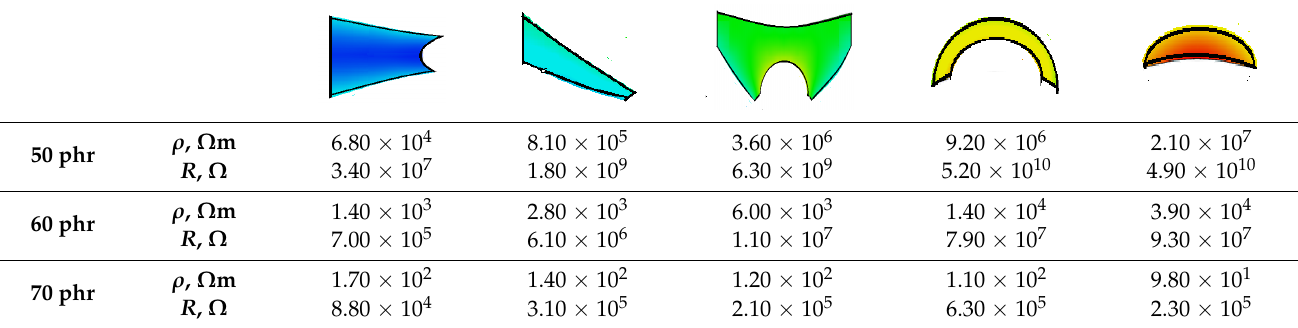
Table 3. The calculated resistivity and resistance of separate domains (samples type c).